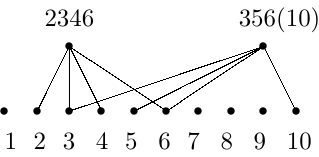
Figure 2: The bipartite graph of the involution 1462(10)37985